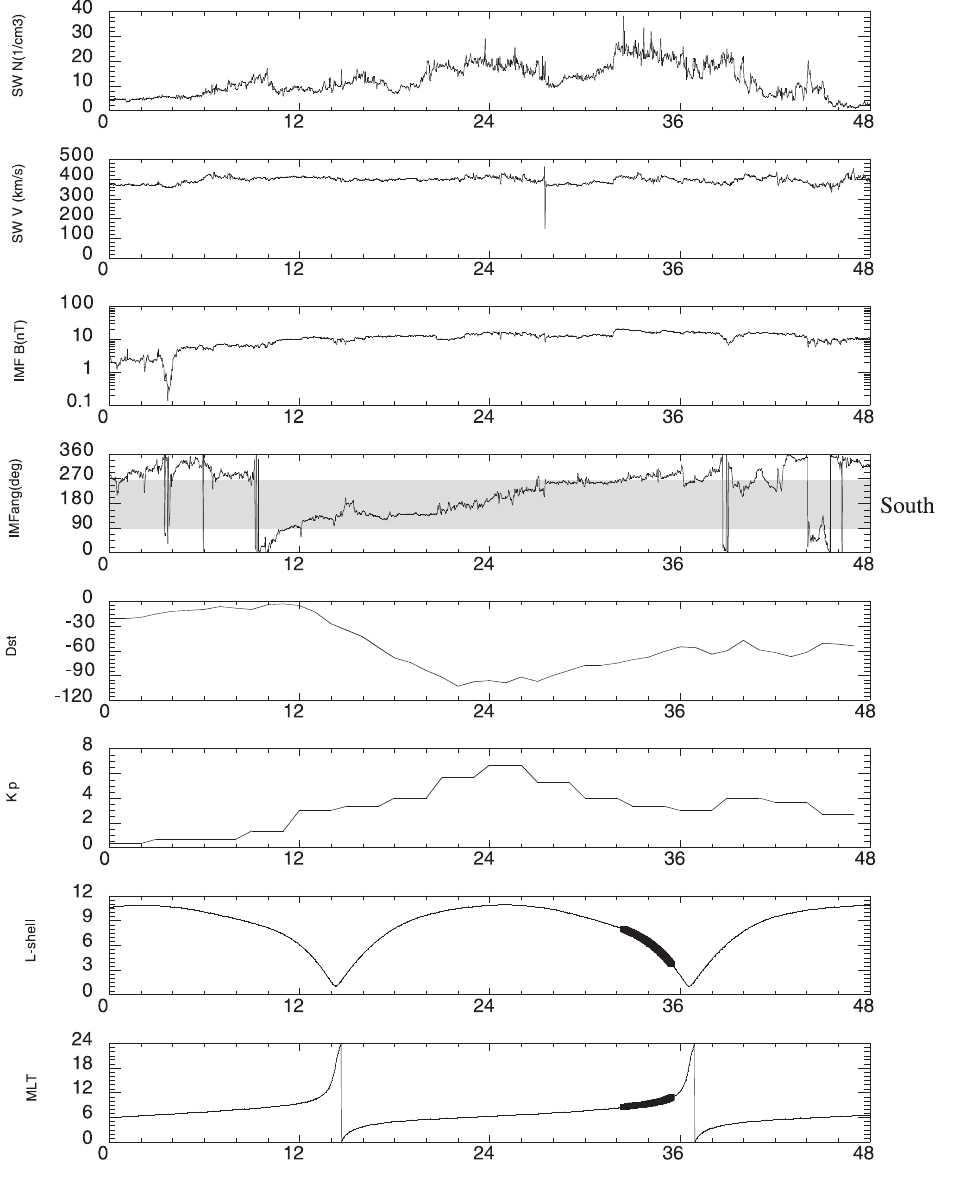
Fig. 2. Solar wind and magnetic field parameters from the MFI and SWE instruments on the Wind spacecraft, Dst and Kp indices, and L -shell and magne- tic local time for the Equator-S spacecraft. The Wind parameters have been shifted in time by